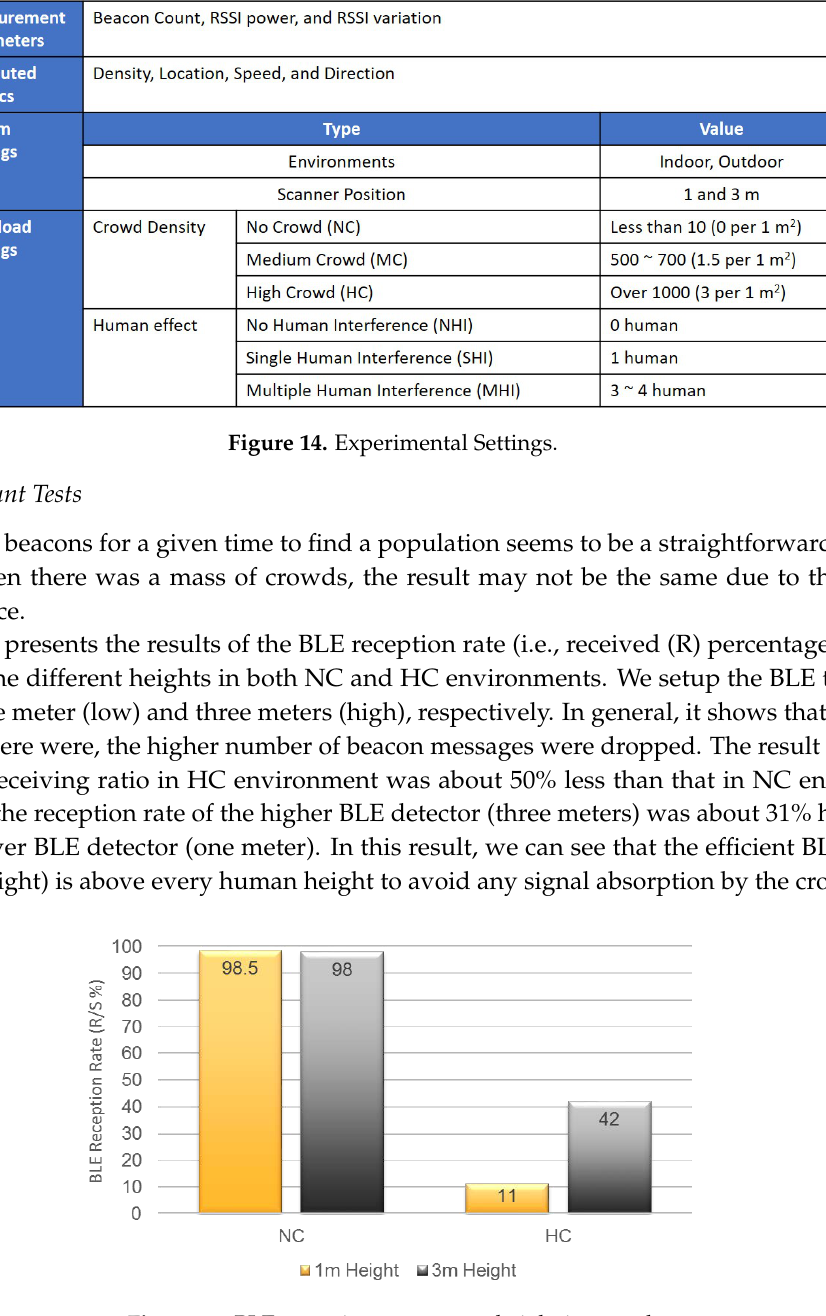
Figure 15. BLE reception vs. scanner height in